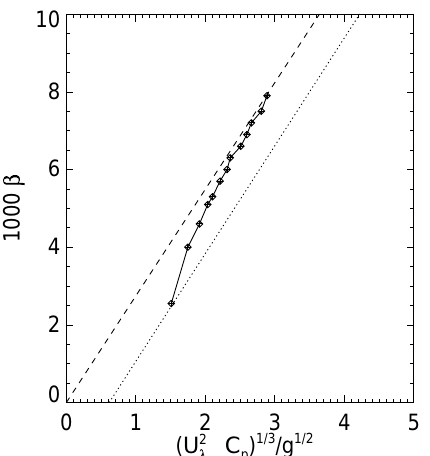
Figure 11. Experimental, theoretical and numerical evidence of the c p ) 1 / 3 /g 1 / 2 . Dashed line – theoreti- dependence of 1000 β on (u 2 λ cal prediction Eq. (10) for λ = 2 . 74; dotted line – experimental re- gression line from Resio et al. (2004) and Long and Resio (2007). Line connected diamonds – results of numerical calculations for the wind speed U = 10ms − 1 duration limited case. Being parameter- ized by dimensionless time tg/U , the numerical simulation trajec- tory evolves from the left to the right on the graph, covering a time span from tg/U = 0 to tg/U (cid:39) 3 . 5 × 10 5 .